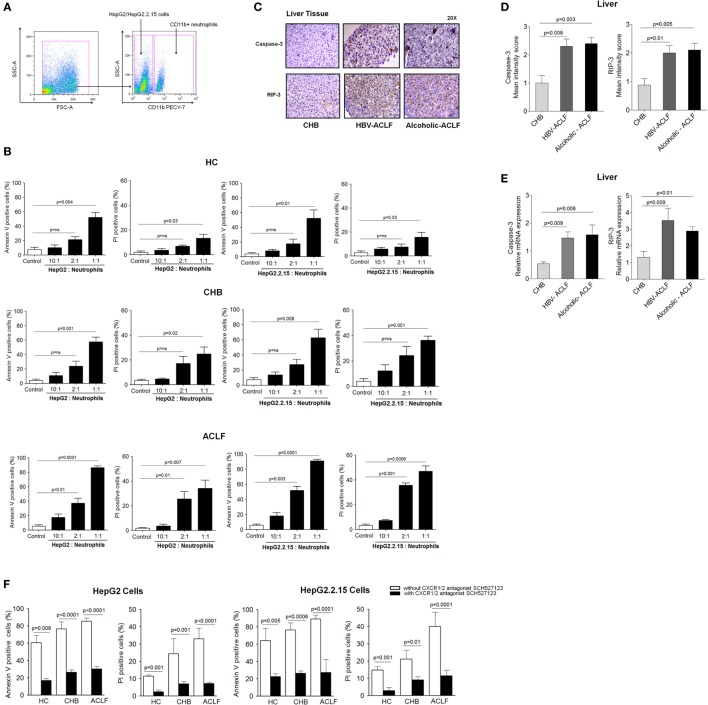
CXCR1/2 receptors blockade with SCH 527123 antagonist prevent contact-dependent cell death. (A) Gating strategy for neutrophil and HepG2/HepG2.2.15 coculture. For coculture experiments, neutrophils were isolated from health subjects and patient groups (n = 15). During quantification of cell death, neutrophils were excluded during flow cytometry analysis and only HepG2 and HepG2.2.15 cells were analyzed. (B) Coculture of HepG2 and HepG2.2.15 cells with increasing no. of neutrophils resulted in significant contact-dependent cell death of HepG2 and HepG2.2.15 cells through apoptosis and necrosis. (C) In liver tissue, hepatocytes showed intense caspase-3 and receptor-interacting protein kinase 3 (RIP-3) staining in acute-on-chronic liver failure (ACLF) (magnification: 20×). (D) In IHC staining, mean intensity score caspase-3 and RIP-3 was higher in ACLF groups than CHB. (E) RT-PCR data revealed high relative mRNA expression of caspase-3 and RIP-3 in ACLF. (F) CXCR1/2 blockade with SCH 527123 antagonist resulted in significant reduction of apoptotic (annexin V-positive cells) and necrotic (PI-positive cells) cell death.